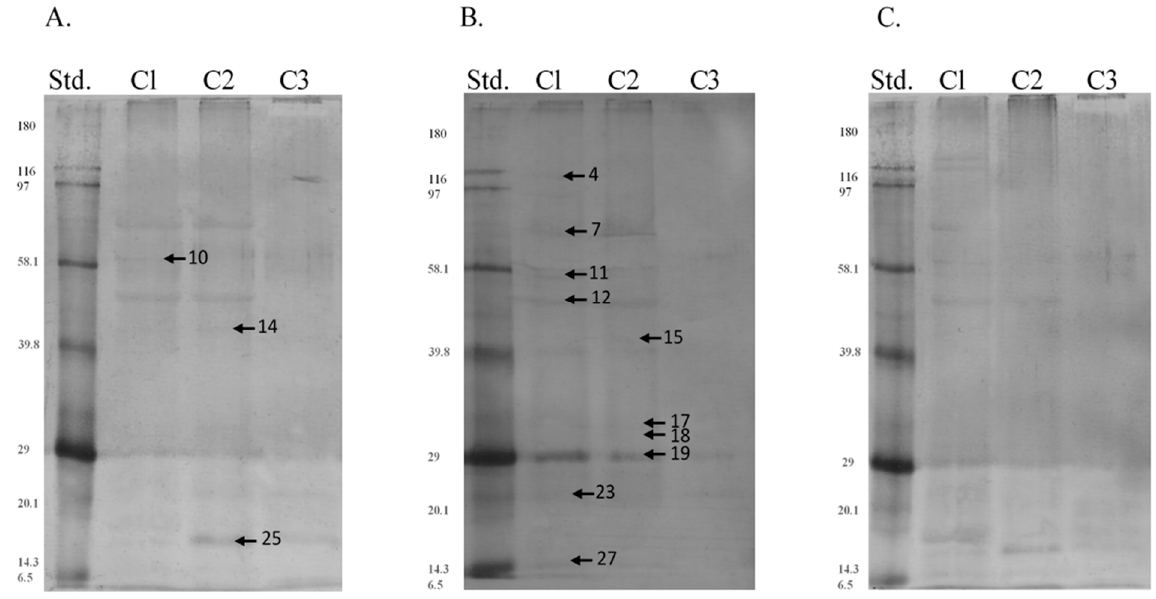
Figure 7. Western blot analysis of phosphoserine ( A ), phosphothreonine ( B ), and phosphotyrosine ( C ) residues obtained from sperm extracts out of the breeding season. Std.—molecular weight standards. C1—caput, C2—corpus, C3—cauda. Phosphoproteins identified by mass spectrometry are marked with arrows (see Table 1).